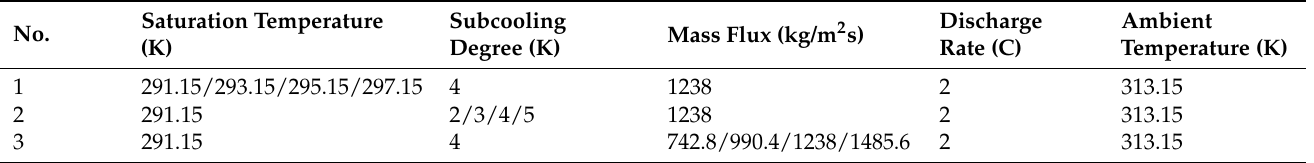
Table 4. Simulation condition of R1233zd